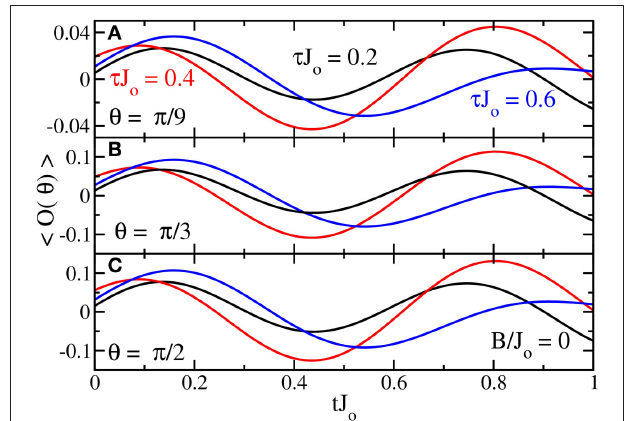
FIGURE 8 | Three different examples of ˆ O ( θ ) as a function of time when τ = 0.2 (black), 0.4 (red), and 0.6 (blue) for θ = π/ 6 (A), π/ 3 (B), and π/ 2 (C) at B / J o = 0 . t stop always equals 6 τ here.